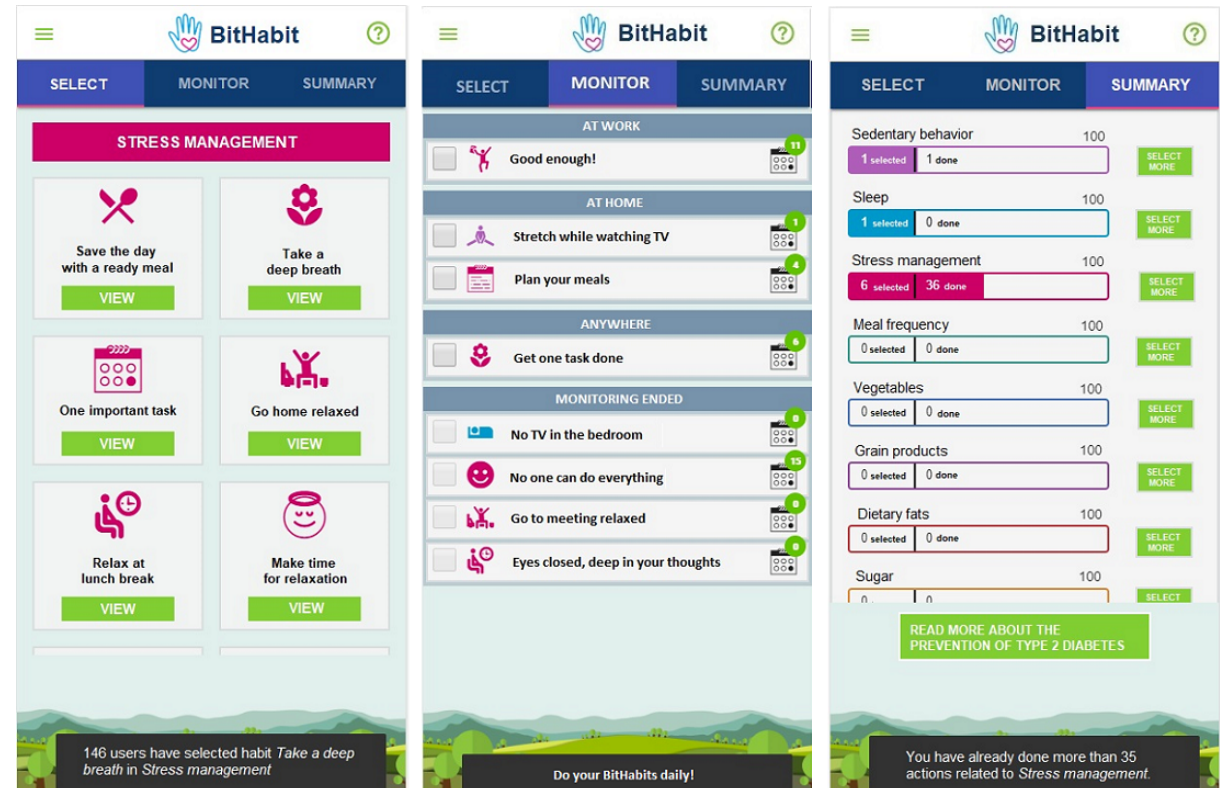
Figure 1. Three main views of the BitHabit